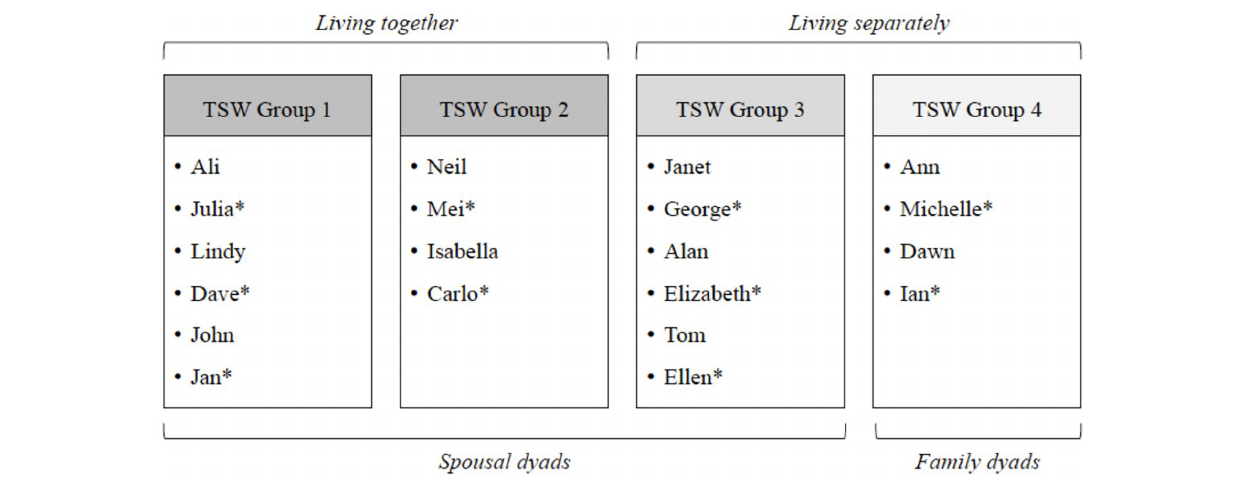
FIGURE 1 | Songwriting groups.